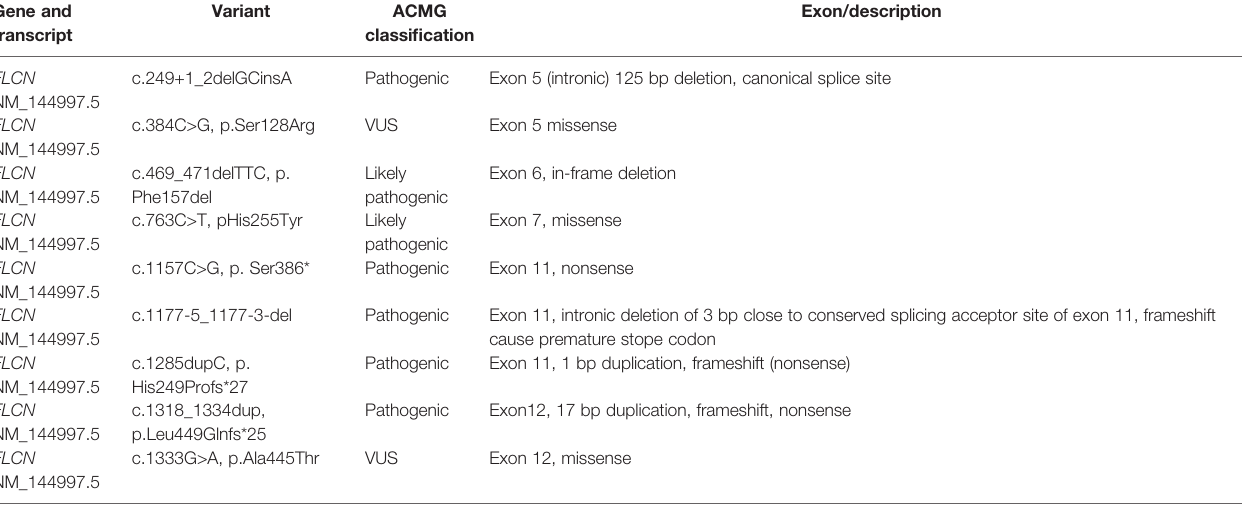
TABLE 3 | Heterozygous FLCN variants identi fi ed on clinically accredited diagnostic testing.